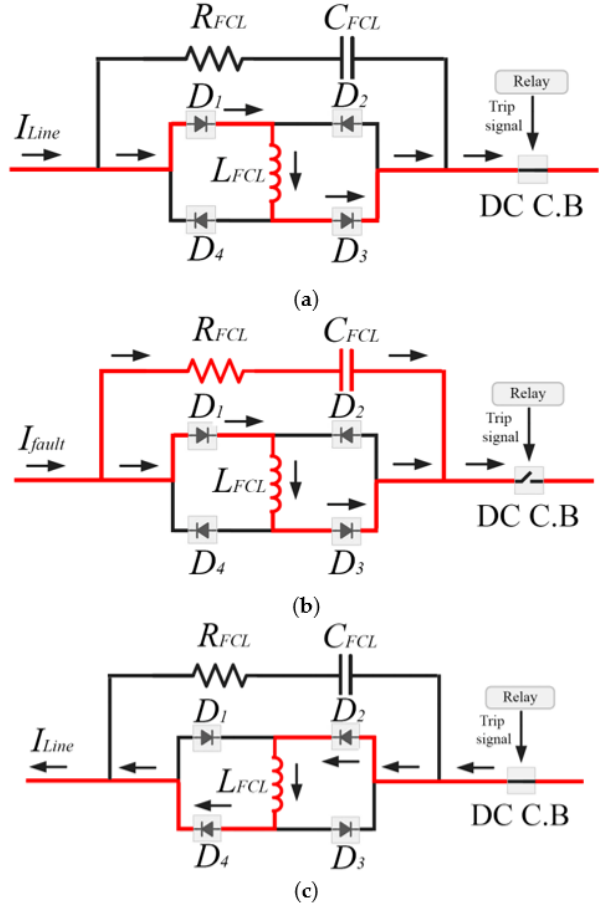
Figure 7. DC FCL-based CB and current flow ( a ) normal, ( b ) fault, ( c ) bidirectional condition. During normal operation, as long as the DC current direction is positive, as shown in Figure 7a, the diodes D 1 -D 3 are in conducting state. On the other hand, during the